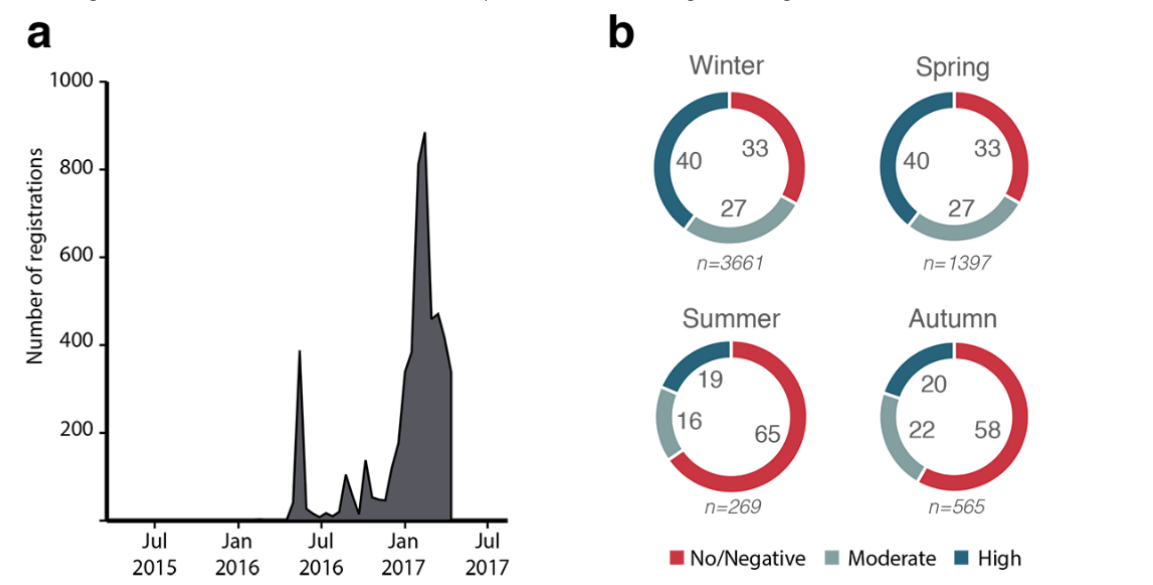
Figure 5. (a) Histogram showing distribution of user registrations in the sample data (N=5892). The main app launch can be identified in May 2016, whereas there is a further rapid acceleration around December 2016, which skews the data toward the winter and spring seasons. (b) User classifications of activity behavior change broken down across seasons; numeric values inside the circles represent the percentage of users in the associated class; sample sizes for each season are shown in italics under each chart. For winter and spring, there is a higher proportion of high activity change users than no or negative change users. Summer and autumn show an over representation of no or negative change